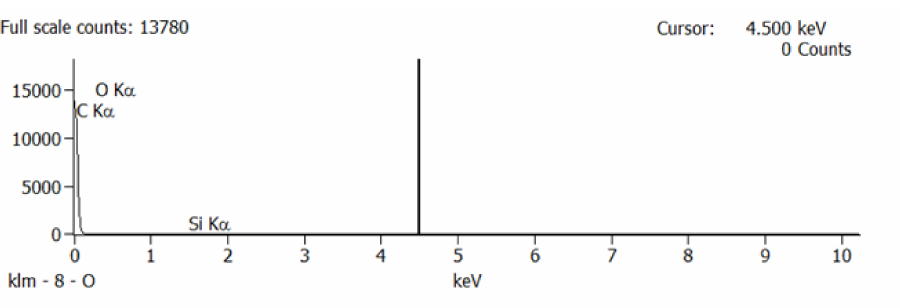
Figure 7. EDX result of metal bracket.